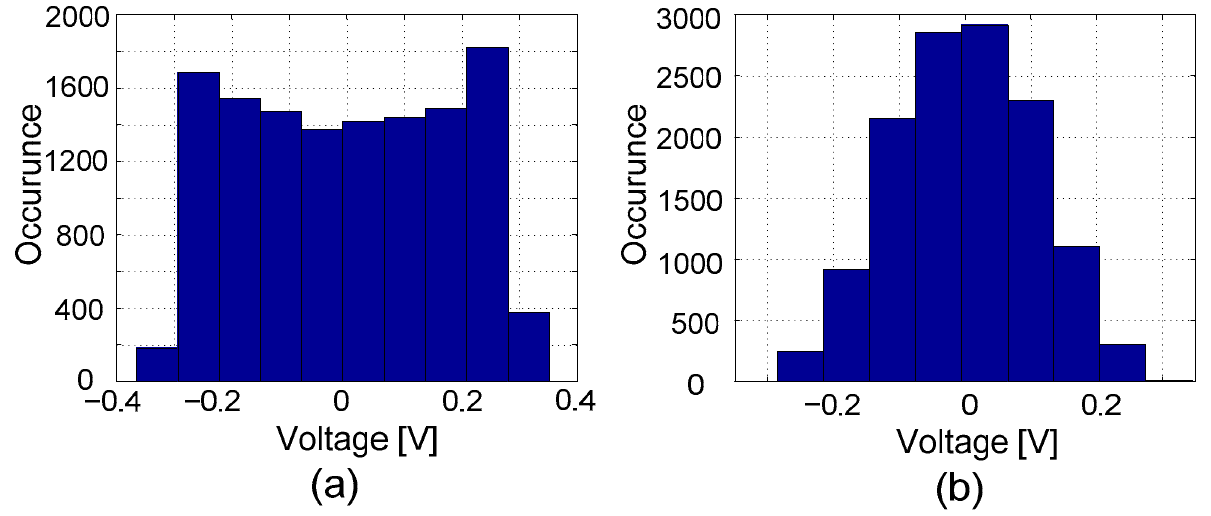
Figure 7. The simulated output range of ( a ) the 1st stage integrator and ( b ) the 2nd stage integrator. We also evaluated the impact of the amplifier nonlinearity using behavioral sim- ulations. Specifically, since most differential amplifiers suffer from compressive gain nonlinearity versus input magnitude, we use the following gain